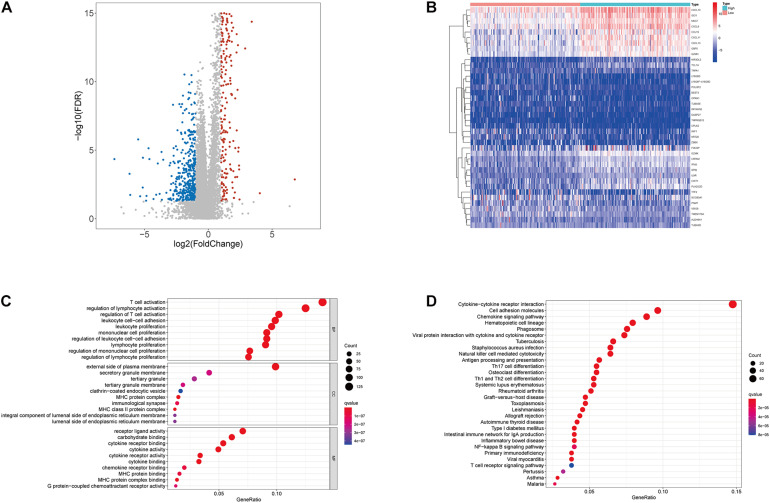
Volcano plot, Heatmap, and enrichment analysis of GO and KEGG for DEGs. (A) Volcano plot for DEGs. The blue and red dots represented the significantly downregulated and upregulated genes, respectively; and the gray dots represented the genes without differential expression. FDR < 0.05, | log2 FC | > 1 and p < 0.05 (B) Heatmap for DEGs generated by comparison of the high score group vs. the low score group in ImmuneScore. The row name of heatmap is the gene name, and the column name is the ID of samples which not shown in the plot. DEGs were determined by Wilcoxon rank sum test with FDR < 0.05 and | log2 FC | > 1 as the significance threshold. (C,D) GO and KEGG enrichment analysis for 1067 DEGs, terms with p and q < 0.05 were believed to be enriched significantly.